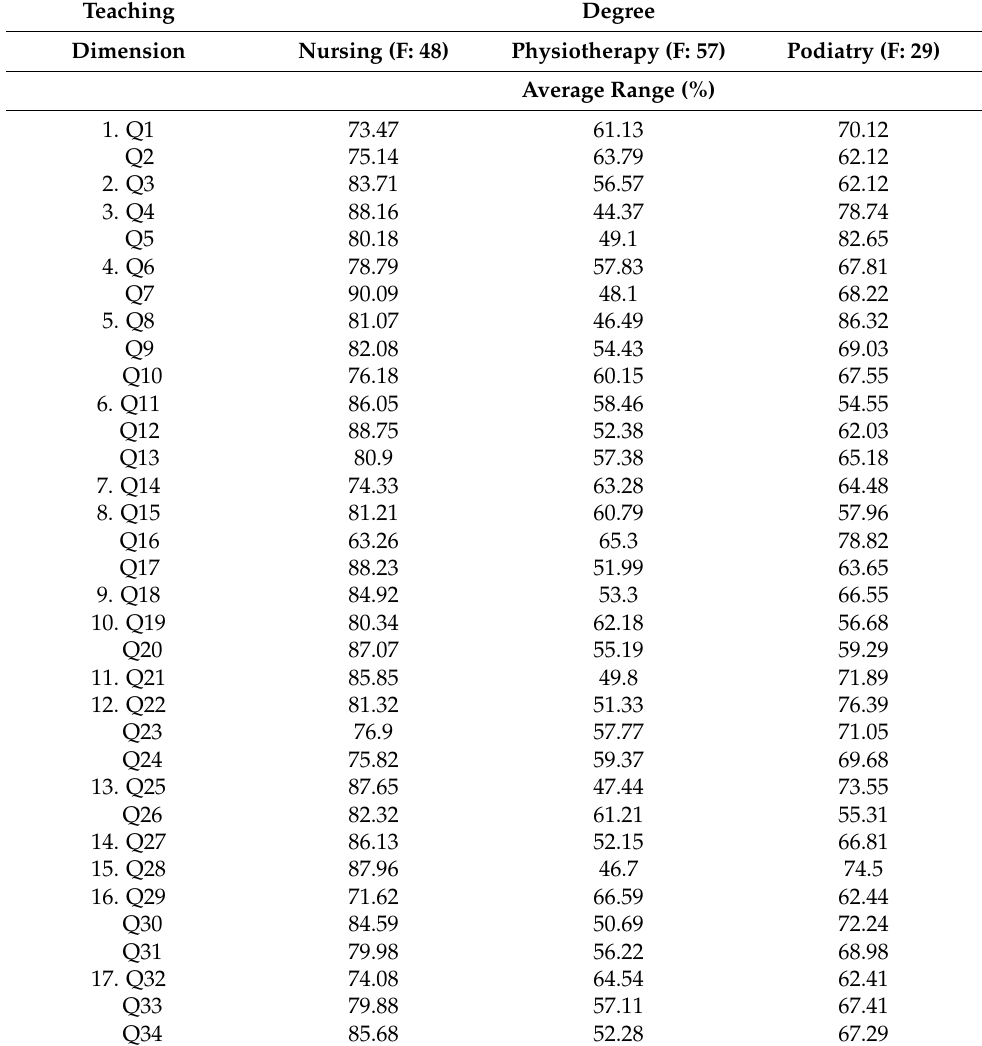
Table 4. Average range obtained in each degree according to the teaching dimension.